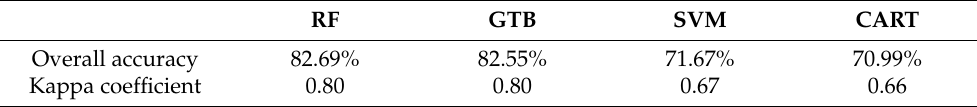
Table 8. Fifteen feature variables with the importance score ranks for the four